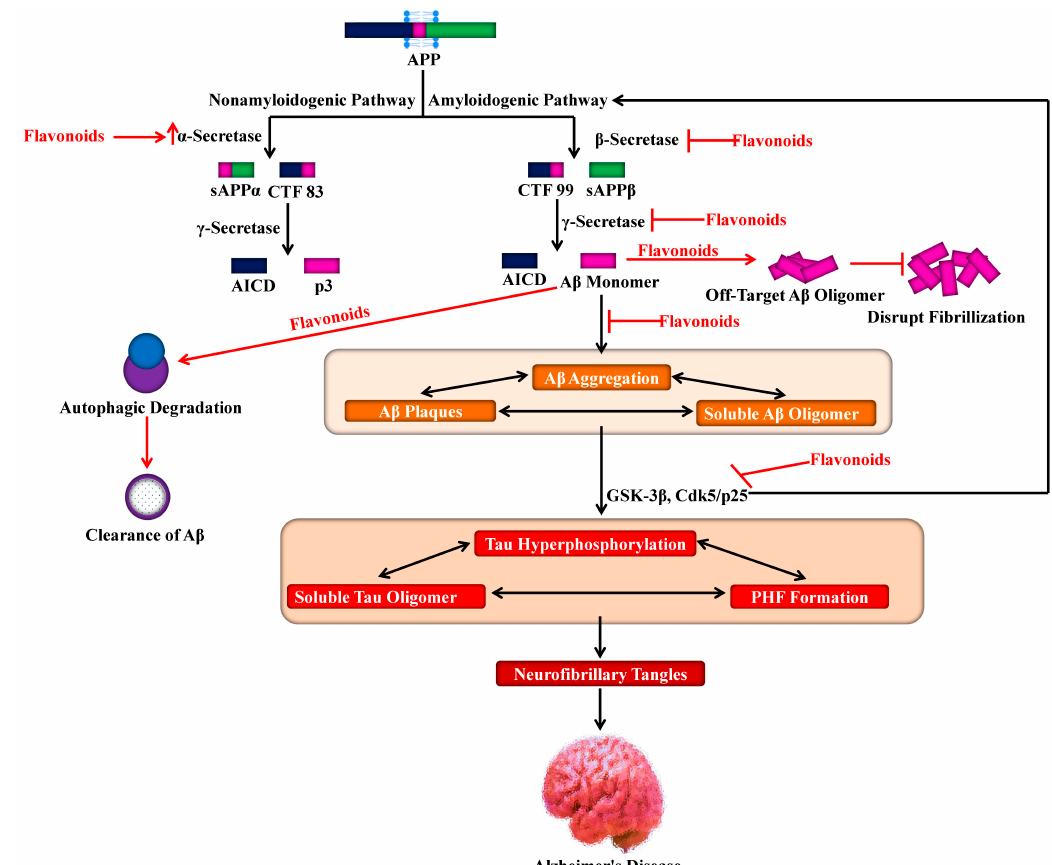
Figure 4. Role of flavonoids in targeting amyloid precursor protein processing for lessening Alzheimer’s pathogenesis. APP, amyloid precursor protein; sAPP, soluble amyloid precursor protein; CTF, C-terminal fragment; A β , amyloid beta; AICD, APP intracellular domain; p3, a peptide; GSK-3 β , glycogen synthase kinase 3 β ; Cdk5, cyclin-dependent kinase 5.